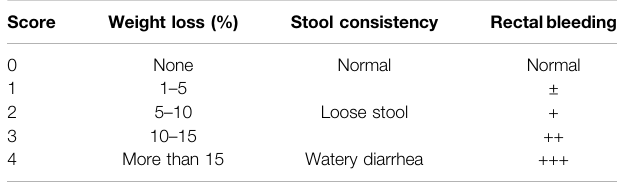
TABLE 1 | The clinical disease activity index (DAI)